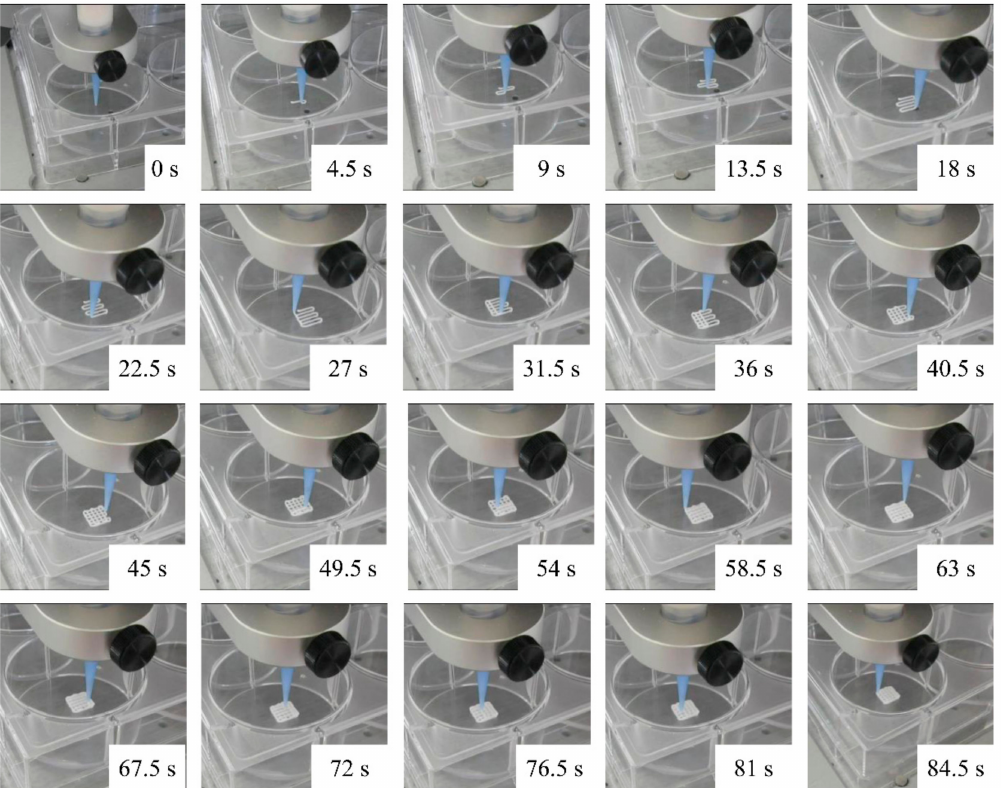
Figure 3. Time-lapse pictures of 3D-plotting process of a 6 mm x 6 mm, 6 strand scaffolds with an alternating layer pattern (0 ◦ /90 ◦ , ABAB).